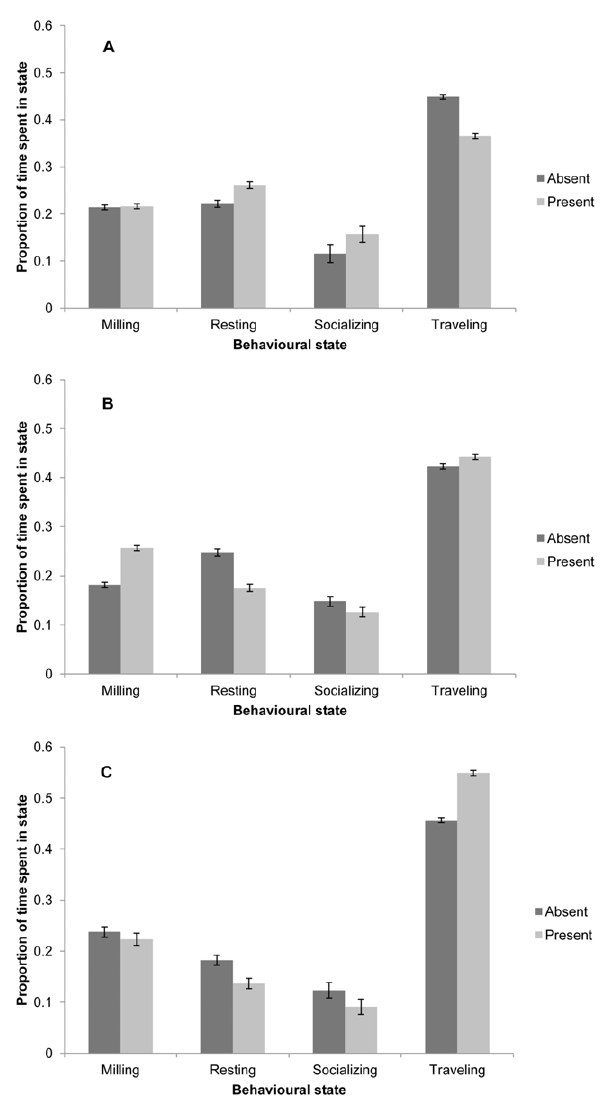
Figure 4. Diurnal variation in the behavioural budget of dolphin groups in the presence and absence of vessels. Behavioural budget split by A) Morning, B) Midday, and C) Afternoon. Error bars are 95% confidence